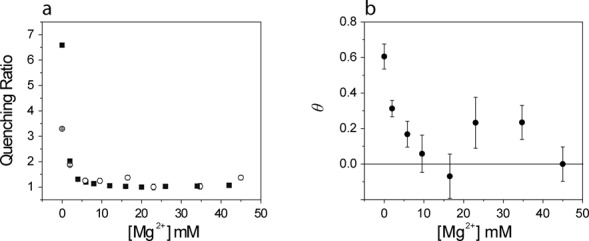
Fluorescence intensity and lifetime ratio functions (see text) for L(dAp)ER(Bim) a function of [Mg2+]. (a) \documentclass[12pt]{minimal}
\usepackage{amsmath}
\usepackage{wasysym}
\usepackage{amsfonts}
\usepackage{amssymb}
\usepackage{amsbsy}
\usepackage{upgreek}
\usepackage{mathrsfs}
\setlength{\oddsidemargin}{-69pt}
\begin{document}
}{}$F_{{\rm max}} /F_k$\end{document}, (open circles) and \documentclass[12pt]{minimal}
\usepackage{amsmath}
\usepackage{wasysym}
\usepackage{amsfonts}
\usepackage{amssymb}
\usepackage{amsbsy}
\usepackage{upgreek}
\usepackage{mathrsfs}
\setlength{\oddsidemargin}{-69pt}
\begin{document}
}{}$\tau _{{\rm ampmax}/} \tau _{{\rm amp},k}$\end{document} (filled squares). (b) Fraction of probe (θ) involved in static G–Bim complex formation.